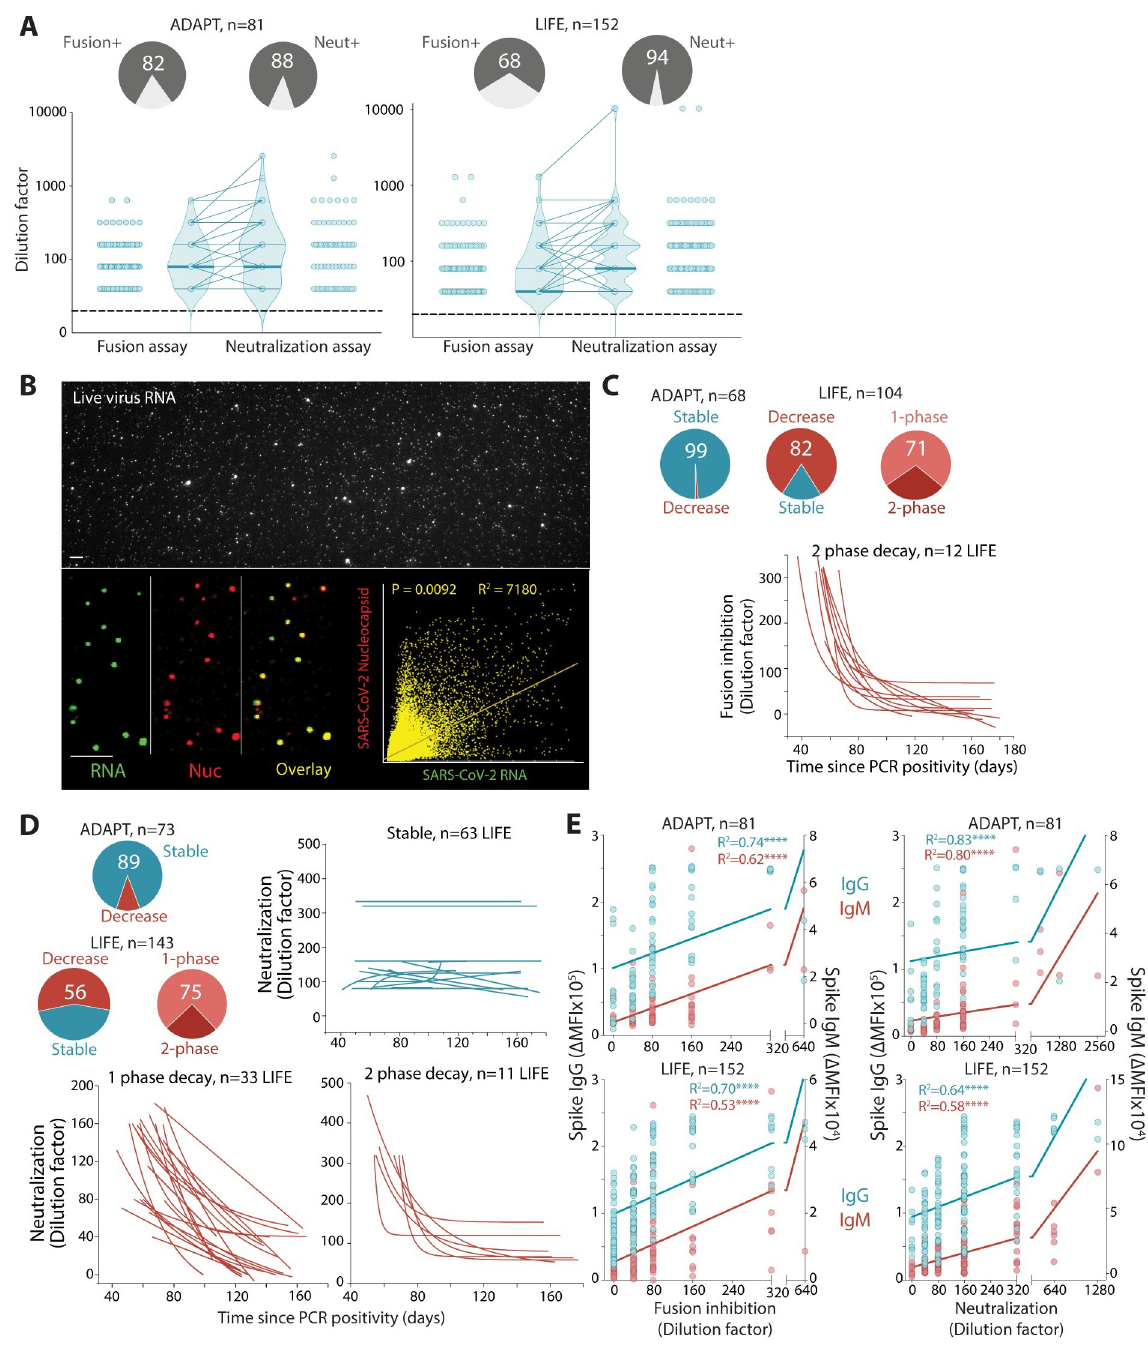
Fig 2. Viral neutralization and inhibition of viral–cell fusion are strongly correlated with Spike antibody titers and sustained overtime. (A) 68%–82% of convalescent sera inhibited virus–cell fusion, whereas 88%–94% sera neutralized live authentic SARS-CoV-2. Neutralization titers were higher than viral–cell fusion titers in ADAPT (ns, not significant) and LIFE ( P < 0.0001). (B) Approximately 75% of virus particles were SARS-CoV-2 Nucleocapsid- and RNA positive (overlay, yellow). (C) All but one ADAPT patient had stable responses over time, whereas most LIFE donors (82%) had a decreased virus–cell fusion over time, with the majority (71%) exhibiting a single-phase decay. (D) In sera capable of viral neutralization, most ADAPT sera were stable (89%), whereas most LIFE sera (56%) had a decreased score over time, with the majority (75%) exhibiting a single-phase decay. Serum curves unable to be fitted were classified as undetermined. (E) Spike IgG and IgM levels were correlated with inhibition of virus–cell fusion and neutralization scores. R 2 values are shown, and ���� indicates significance ( P < 0.0001). SARS-CoV-2, Severe Acute Respiratory Syndrome Coronavirus 2.